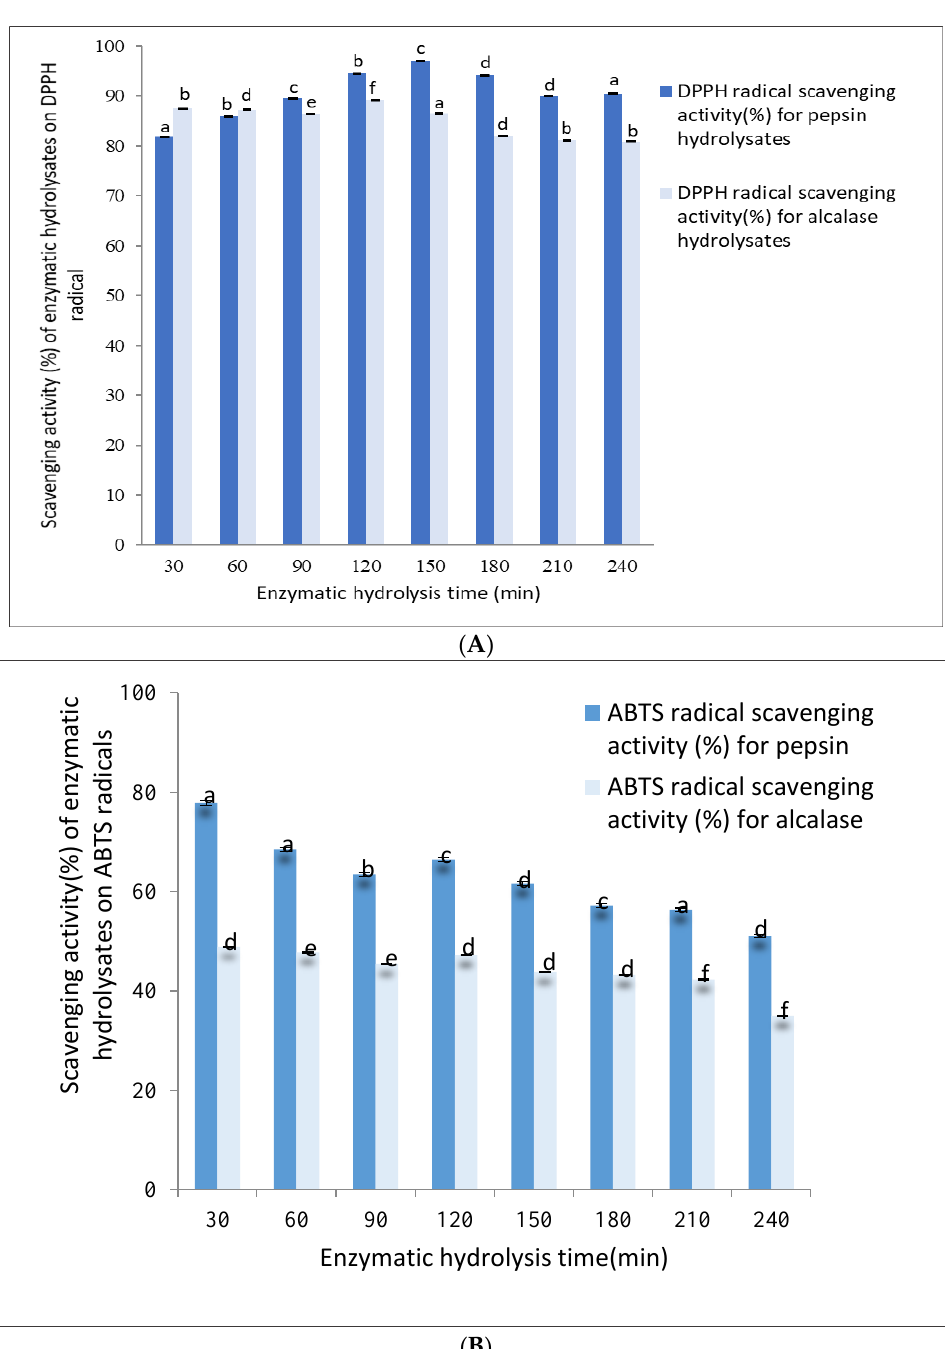
Figure 2. Antioxidant activities of pepsin and alcalase hydrolysates on ( A ) DPPH (1,1-diphenyl-2- picrylhydrazyl) and ( B ) ABTS (2,2 (cid:48) -azino-bis-ethylbenzthiazoline-6-sulfonic acid) radicals. Values with error bars indicate the means and standard deviations, respectively, of triplicate analyses. Values with di ff erent superscripts (a, b, c, ... ) indicate significant di ff erences between the sample means at p <